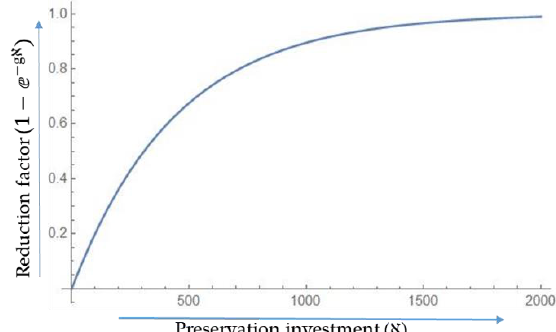
Figure 1 . Investment factor plotted against reduction in deterioration rate. Figure 1. Investment factor plotted against reduction in deterioration